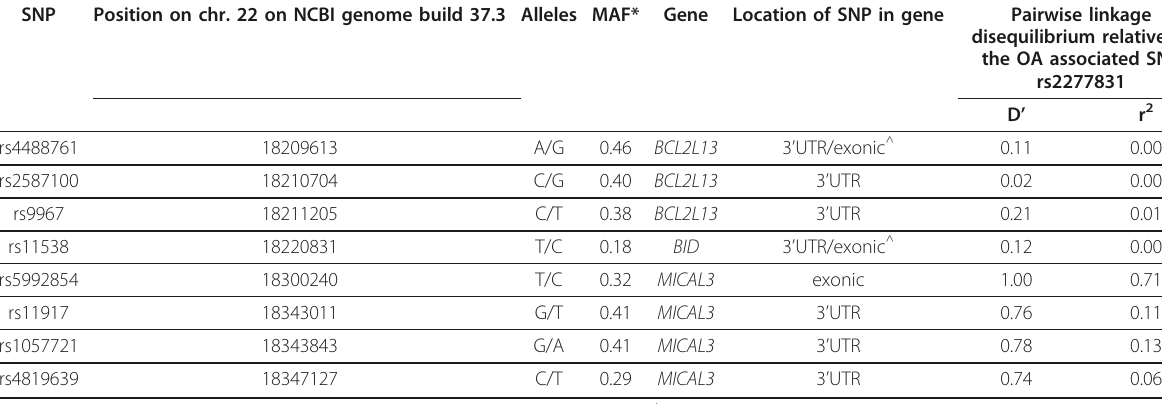
Table 1 The eight transcript SNPs studied in this report SNP Position on chr. 22 on NCBI genome build 37.3 Alleles MAF* Gene Location of SNP in gene Pairwise linkage